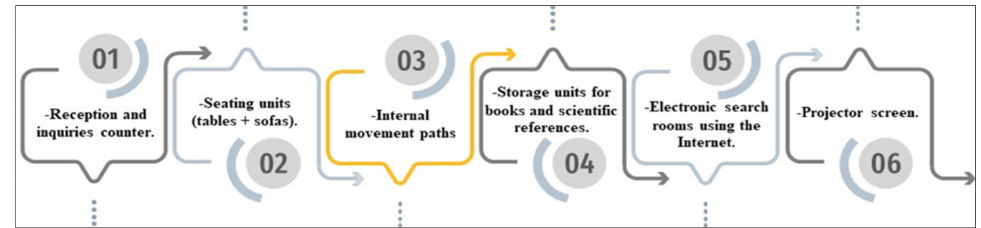
Figure 6. The diagram shows the components of the academic